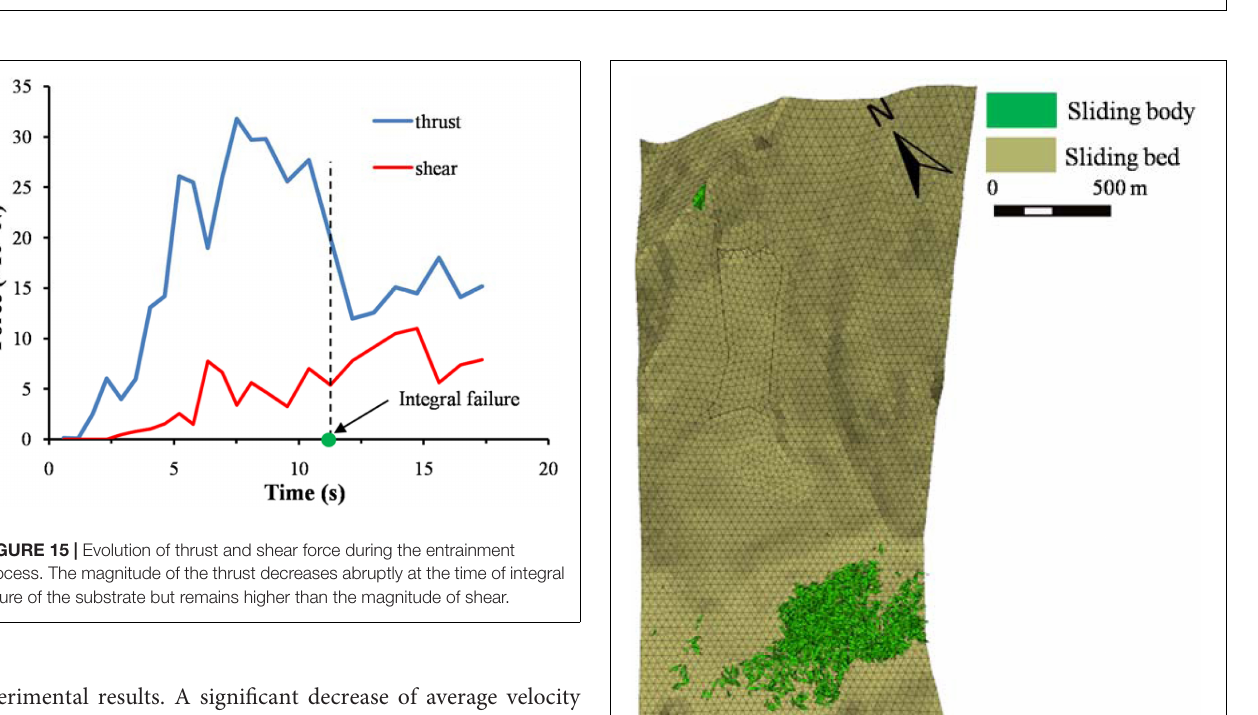
FIGURE 14 | Sketch diagram of the thrust and shear force acting on loose material alone sliding direction in a supply limited condition. The sliding body applying the thrust and shear force is divided into two parts, separated by a plane which passes through the ridge line of deformed path materials and is perpendicular to the movement direction.